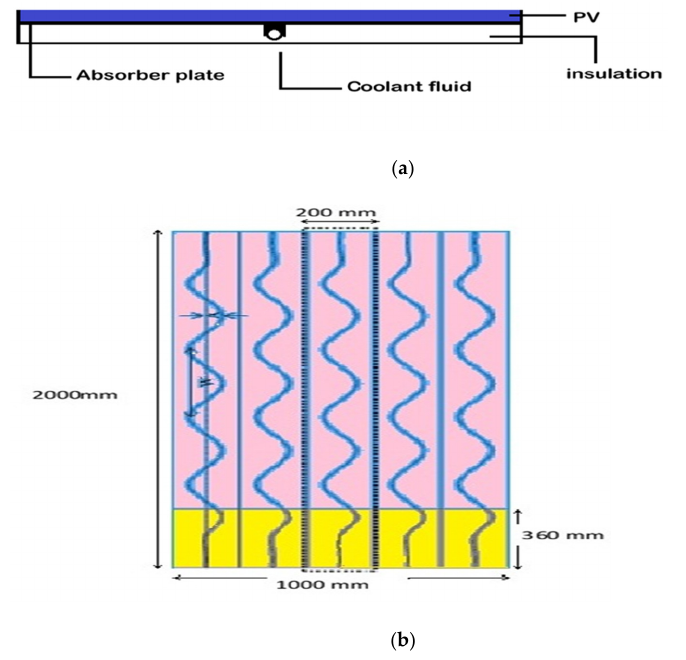
Figure 17. Diagram of the wavy tube with PVT system: ( a ) local cross-section and ( b ) front view.